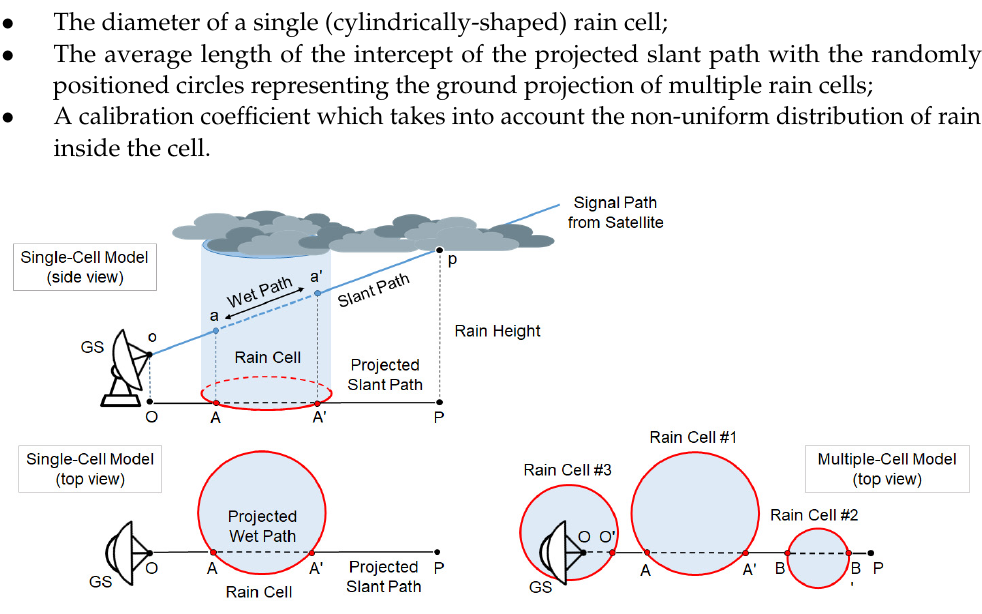
Figure 8. Precipitation modeled as one or more cylindrically-shaped rain cell(s) with uniform RR inside.